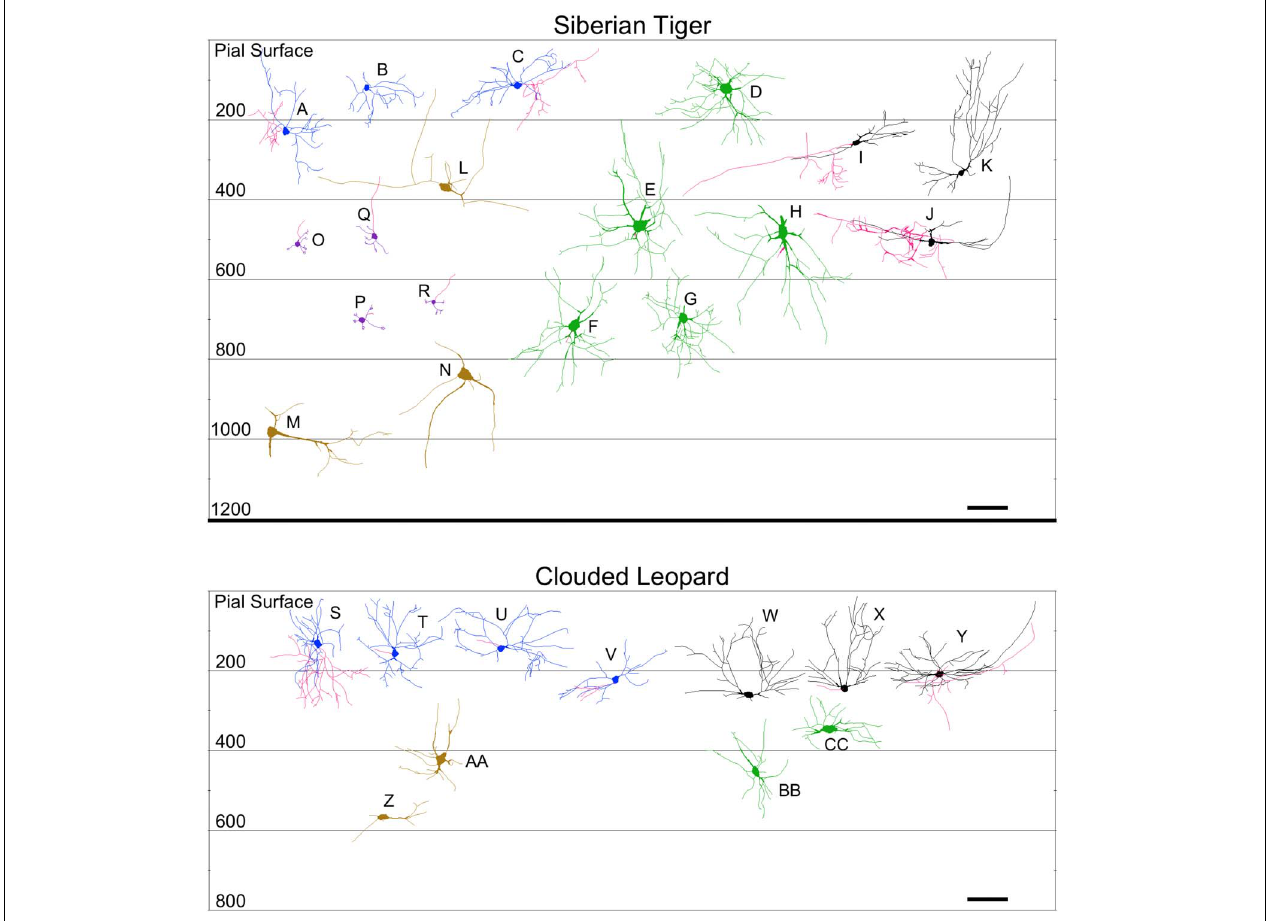
FIGURE 9 | Neurolucida tracings of neurons in the cerebellar cortex of the Siberian tiger (top) and clouded leopard (bottom) indicating relative soma depth from the pial surface (in µ m). Stellate neurons (A–C; S–V) ;